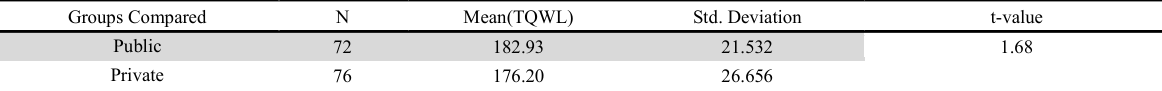
Mean, SD’s and t-value of public and private employees on total QWL Groups Compared N Mean(TQWL) Std. Deviation t-value Private 176.20